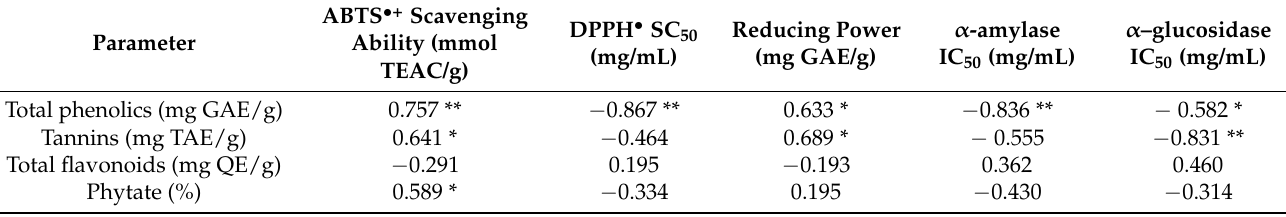
Table 5. Correlations between the bioactive components, antioxidant and starch-hydrolyzing enzymes inhibitory activities of six pipeline Striga -resistant yellow-orange maize hybrids.